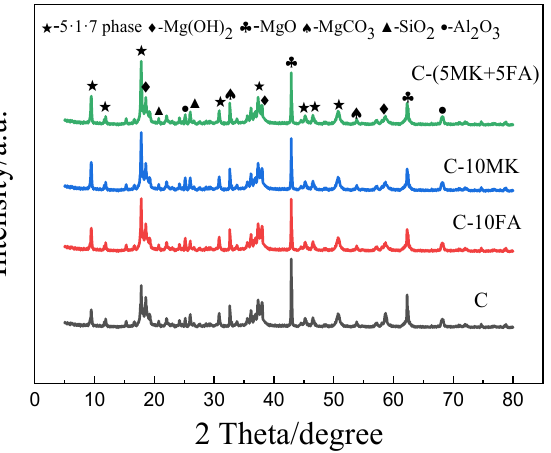
Figure 7. The residual strength and softening coefficient of MOSC with different admixtures im- mersed in water for 28 days (admixture content: 10%).